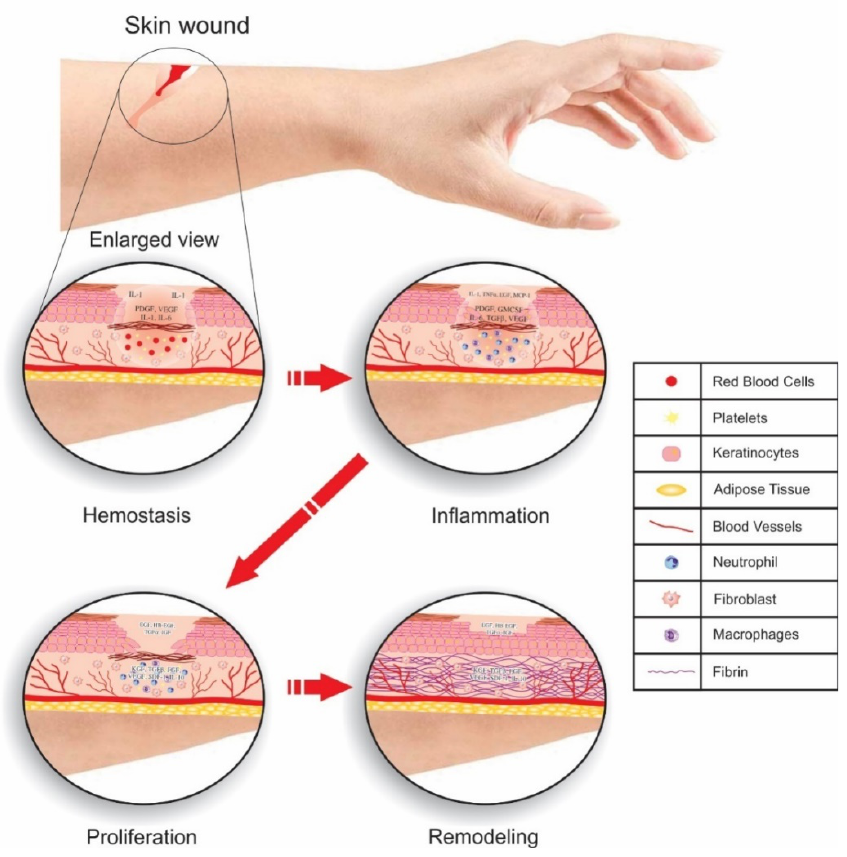
Figure 10. Distinct phases of wound healing in skin illustrate cells and molecules in the tightly controlled process of recovering a healthy barrier.